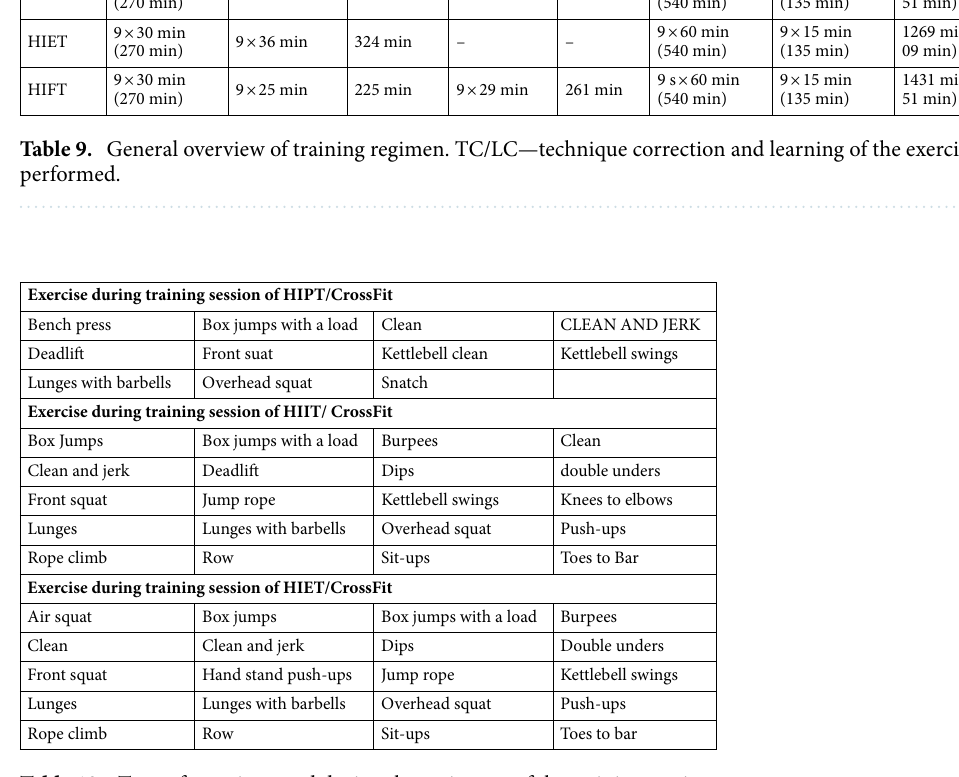
Table 10. Type of exercises used during the main part of the training